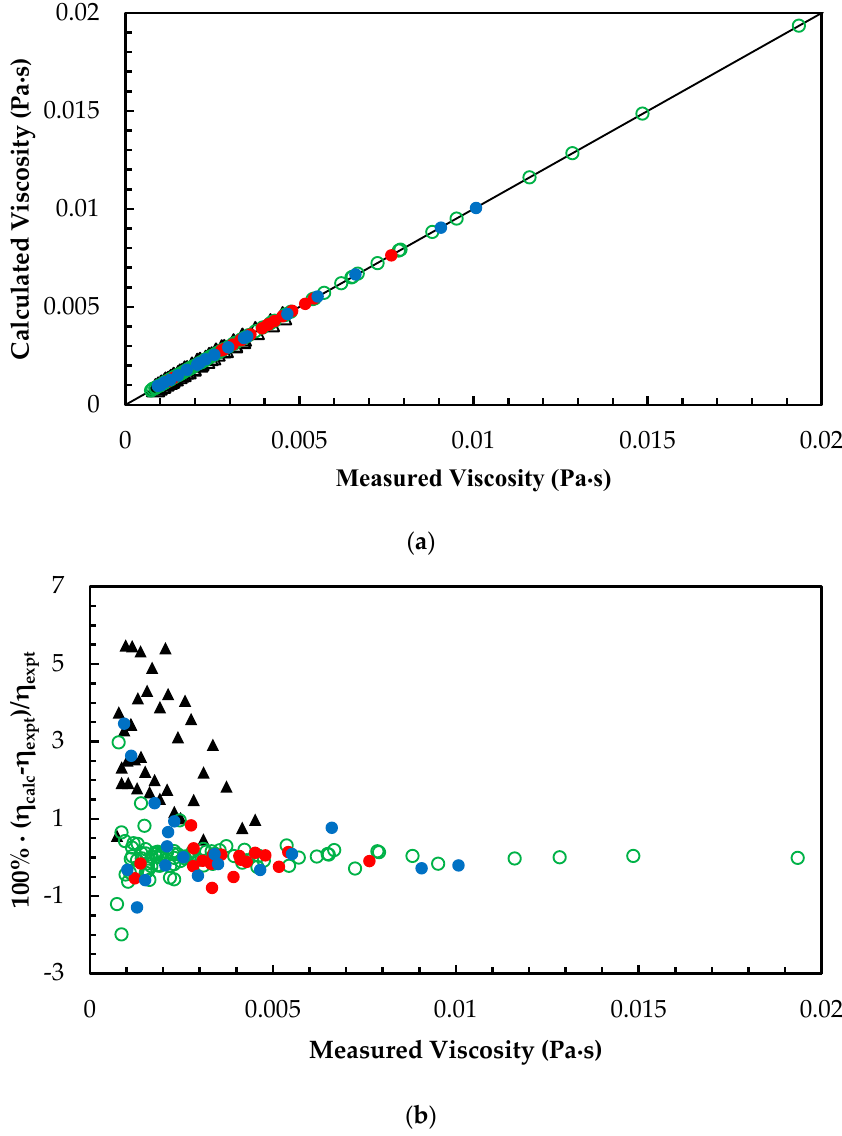
Figure 5. ( a ) Comparison of correlated viscosity with measured viscosity for MEA + H 2 O + CO 2 mixtures. ANN: Training data, ‘ ○ ’; Validation data, ‘ ● ’; Test data, ‘ ● ’. Hartono et al. [11], ‘ ▲ ’. ( b ) Percentage deviation of correlated viscosity from measured viscosity for MEA + H 2 O + CO 2 mixtures. ANN: Training data, ‘ ○ ’; Validation data, ‘ ● ’; Test data, ‘ ● ’. Hartono et al. [11], ‘ ▲ ’.